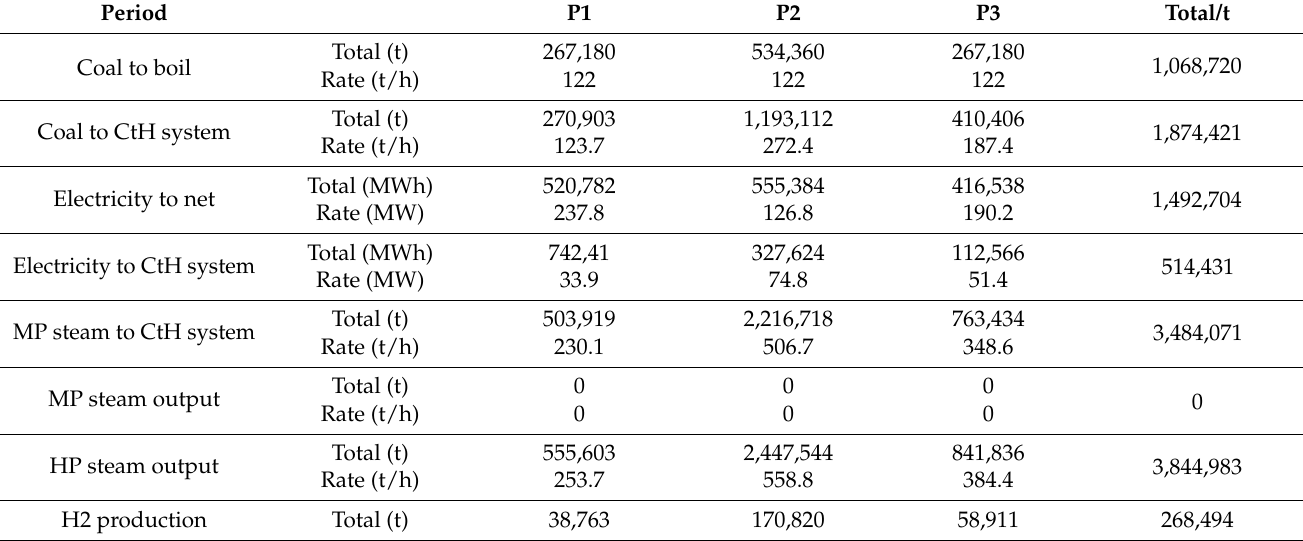
Table 4. Multi-period operating parameters of the integrated